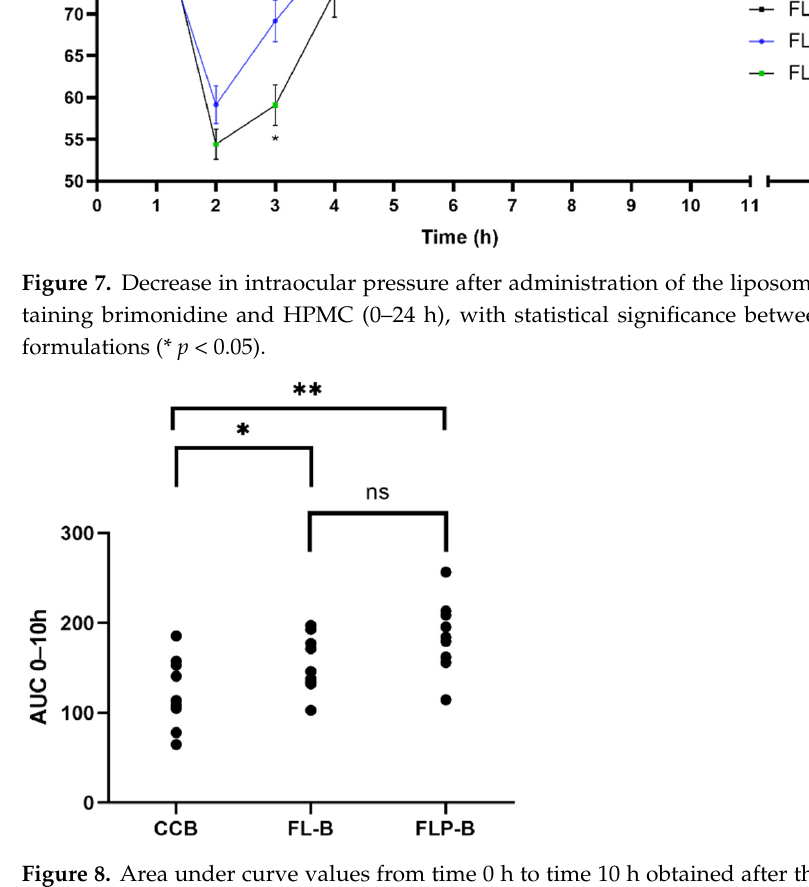
Figure 7. Decrease in intraocular pressure after administration of the liposomal formulation con- taining brimonidine and HPMC (0–24 h), with statistical significance between FL-B and FLP-B for- mulations (* p < 0.05).